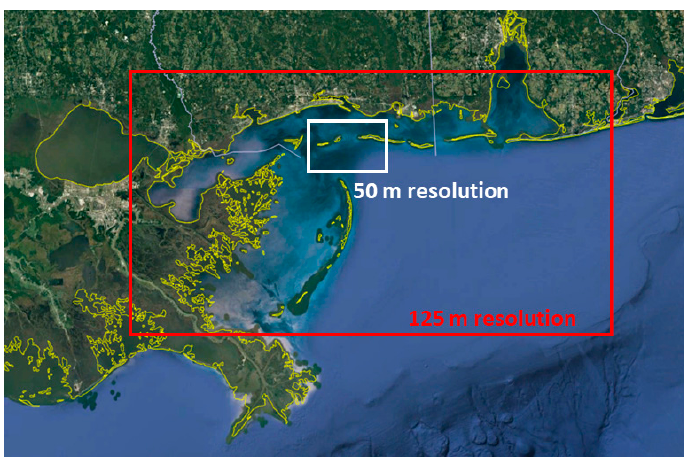
Figure 4. Coupled ocean–atmosphere model domains, northern Gulf of Mexico (outer nest: 125 m resolution, inner nest: 50 m resolution).